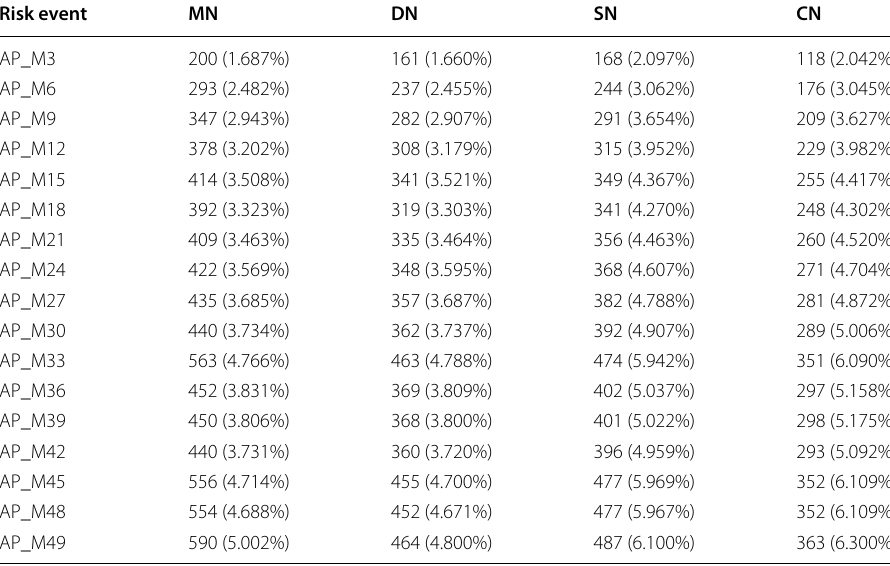
Table 11 Summary statistics of AP in different